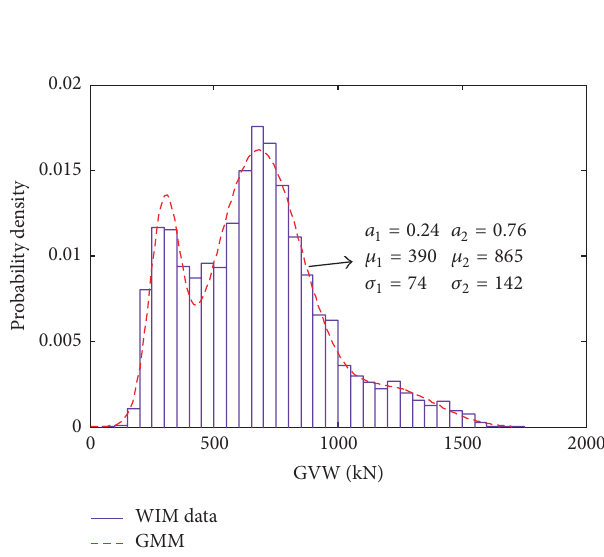
Figure 1: Histogram and PDF of the GVW of the 6-axle